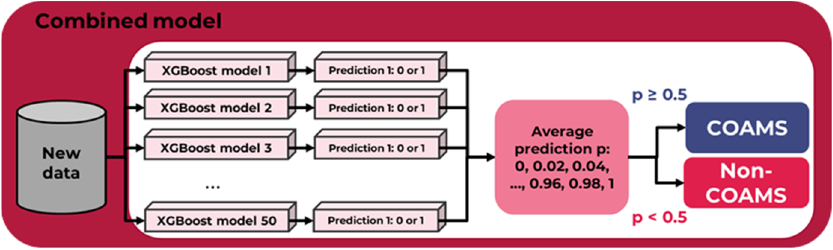
Figure 2. Outline of the combined overall ML model when making predictions for new data. On average, the individual XGBoost classifier models achieved an accuracy of 97%.